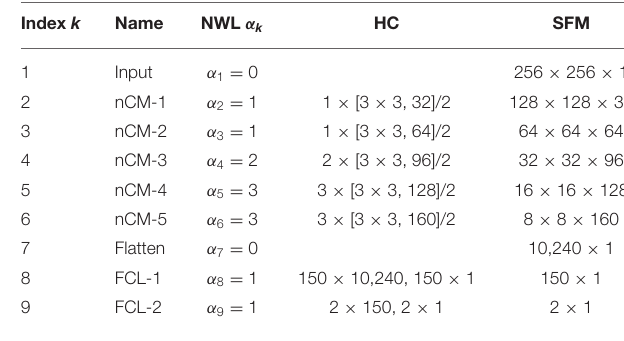
TABLE 2 | Structure of proposed 12l-convolutional neural network backbone